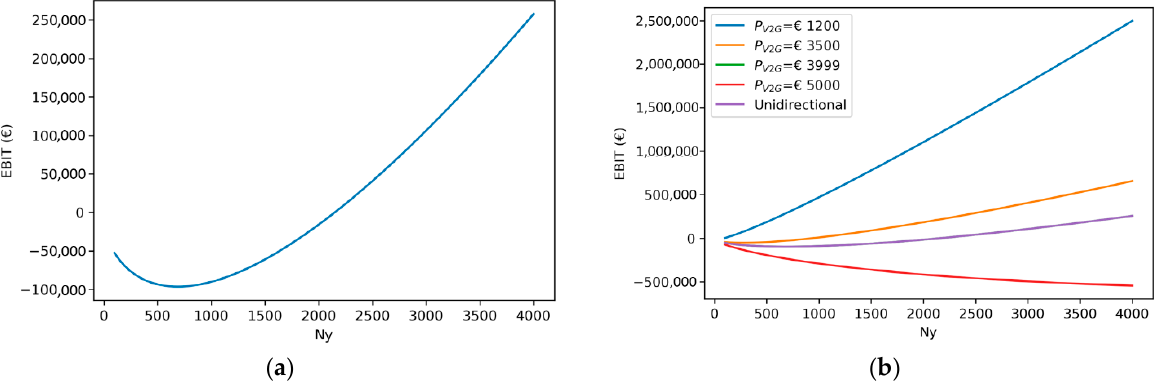
Figure 3. ( a ) EBIT of an entity owning a network of unidirectional EVSE in function of Ny ; ( b ) EBIT of an entity owning a network of V2G EVSE in function of Ny.